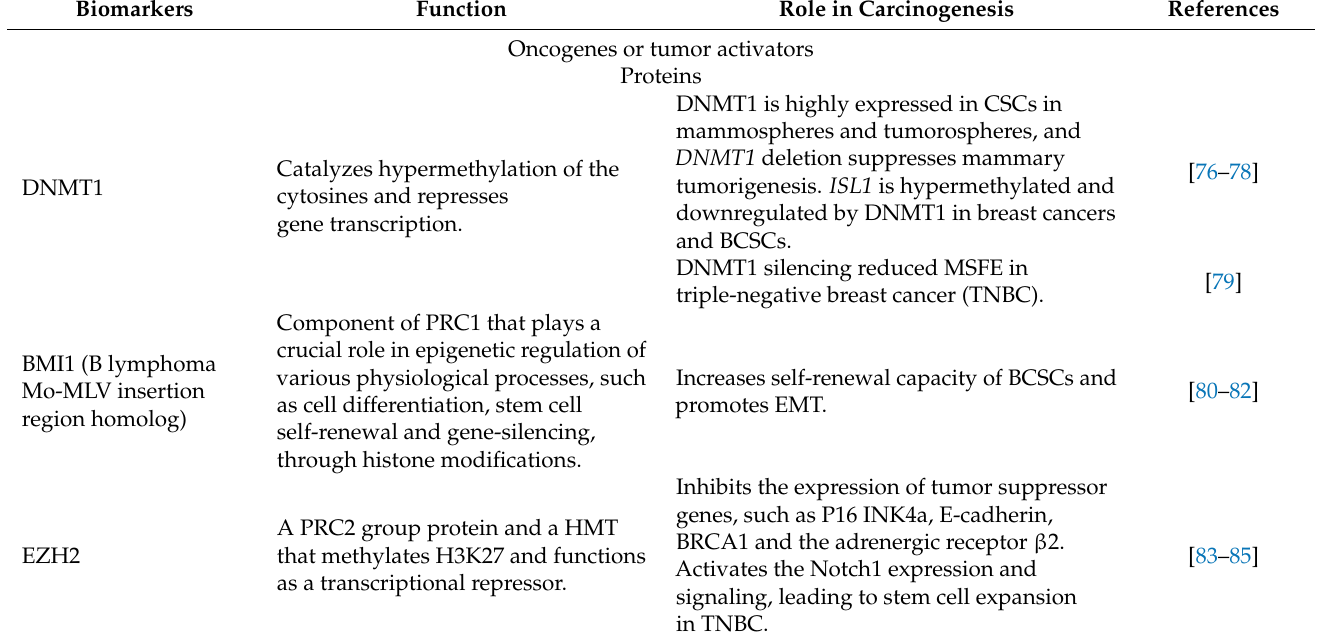
Table 1. Biomarkers involved in epigenetic regulation of carcinogenesis for BCSCs.